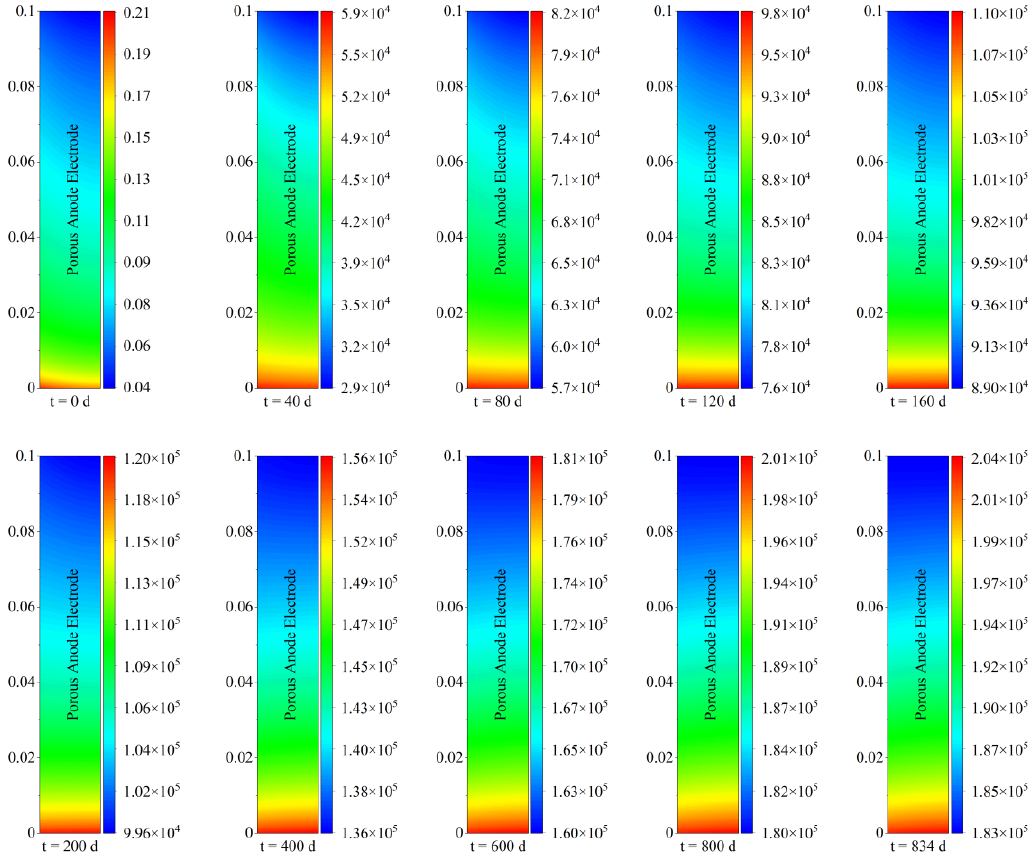
Figure 3. The spatial and temporal evolution of deposited carbon (mol/m 3 ) within the porous anode electrode of the solid oxide fuel cell during 20,000 h of steady − state operation.